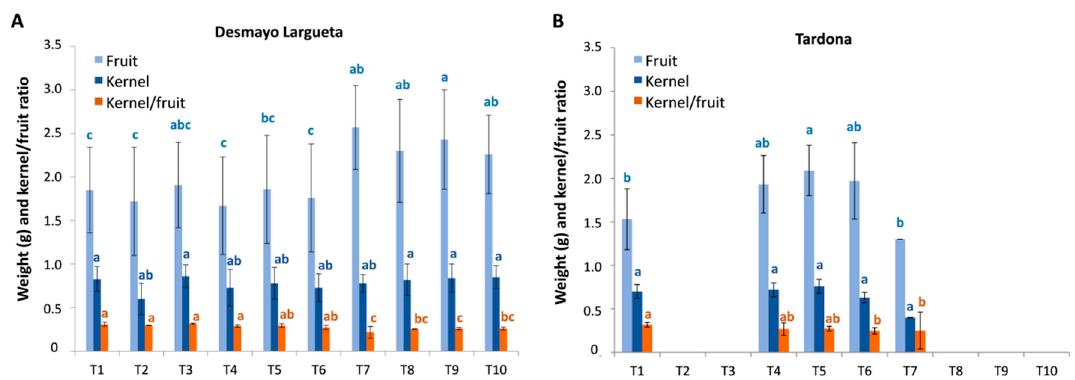
Figure 8. Mean weight and SD of fruits (light blue), kernel (dark blue) and kernel/fruit ratio (orange) per treatment (T) in Season 3. ( A ) Desmayo Largueta cultivar; ( B ) Tardona cultivar. Different letters indicate statistically significant differences based on the Kruskal–Wallis test ( p < 0.05).